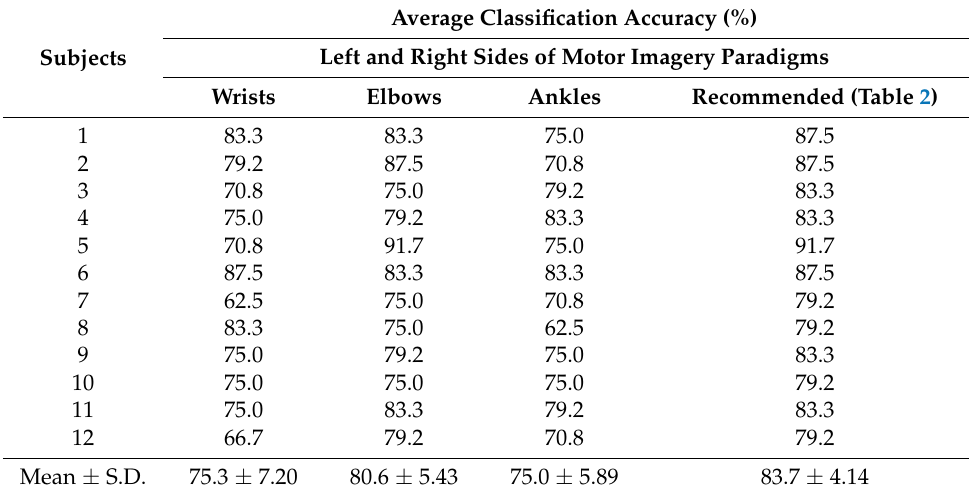
Table 4. Results of using various left/right motor imagery